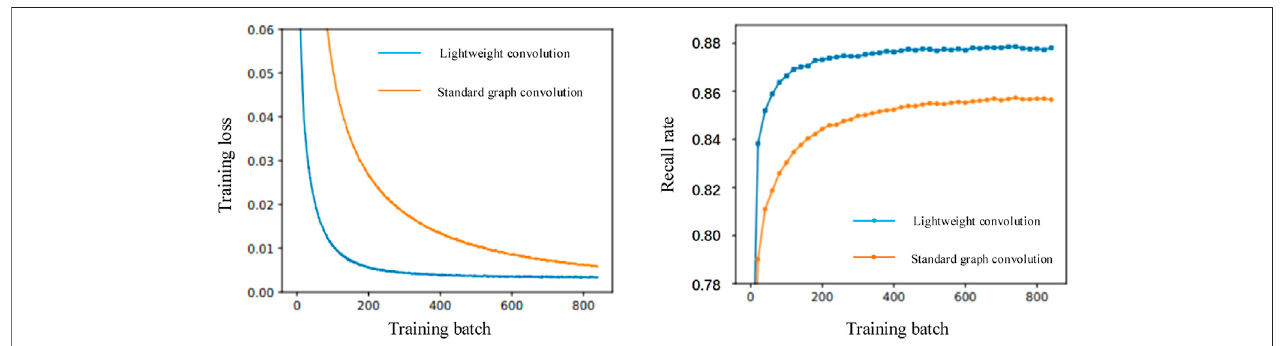
FIGURE 6 | Comparisons of lightweight graph convolution and standard graph convolution.